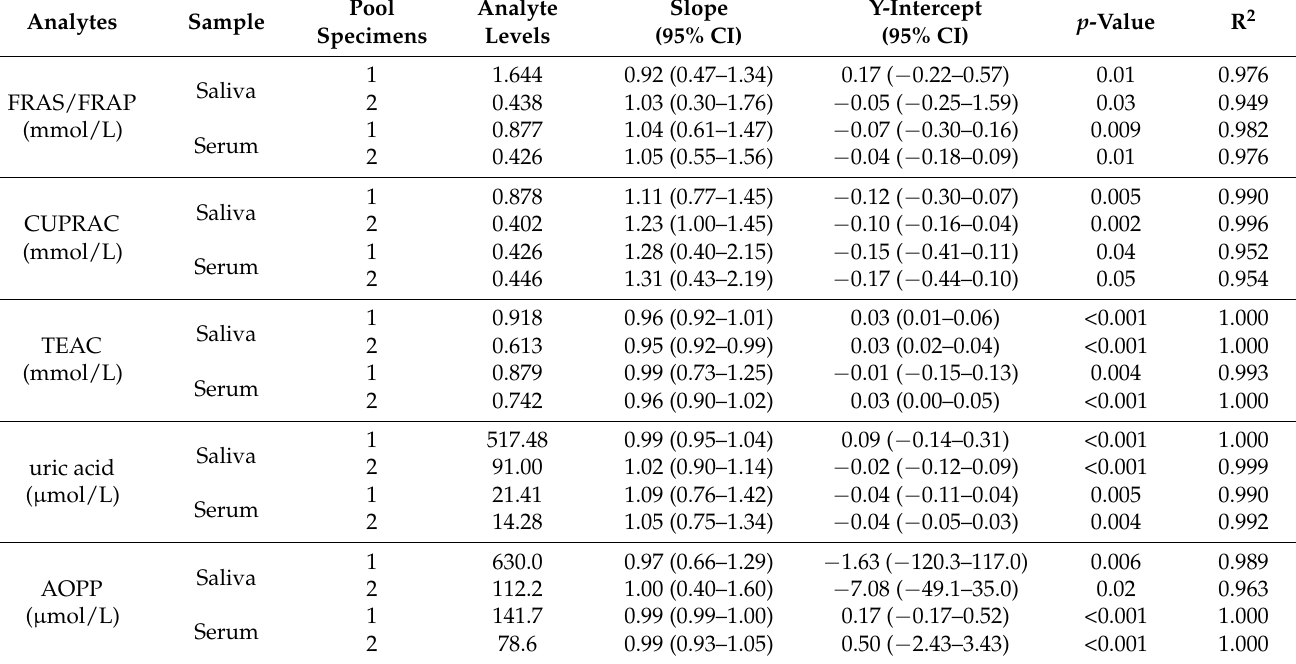
Table 2. Linear regression analysis between expected and observed results from a linearity of dilution study of two pool specimens of horse saliva and serum (1 and 2) with different ferric reducing ability of saliva/serum (FRAS/FRAP), cupric reducing antioxidant capacity (CUPRAC), Trolox equivalent antioxidant capacity (TEAC), uric acid, and advanced oxidation protein products (AOPP)